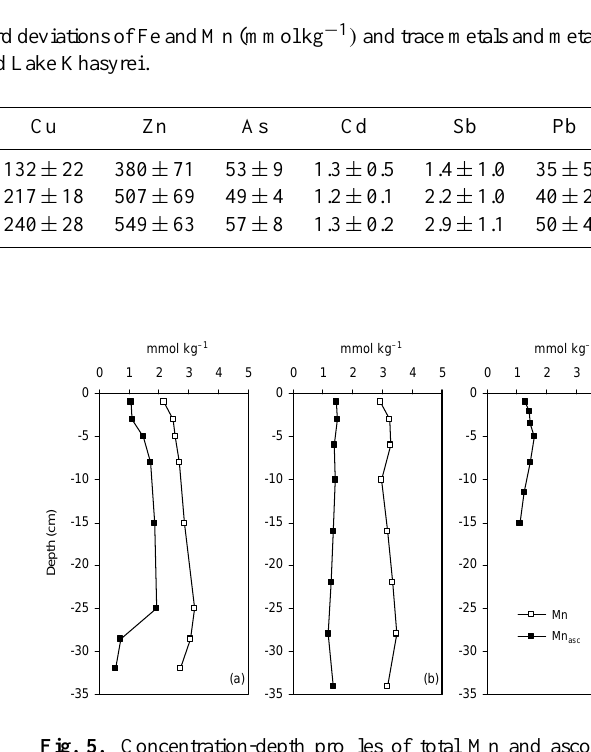
In Lake Shirokoe and Lake Yamsovey, particulate concentra- tions of Co, Ni, Cu, Zn and Pb do not show any pronounced trend with depth (Fig. 6a and b). Antimony profiles are simi- lar in both lakes showing a concentration peak at 3-cm depth followed by more or less constant concentrations downward. 39 µmol kg − 1 ) and Cd (from 1.7 to 0.5 µmol kg − 1 ) in Lake